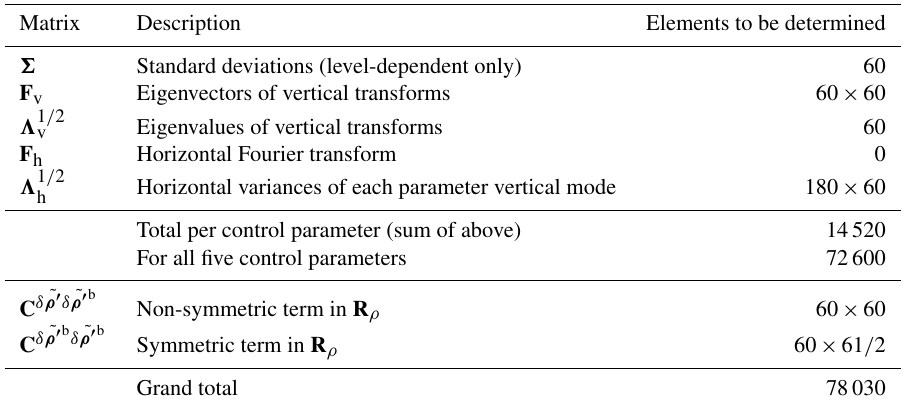
Table A1. The numbers of components of the spatial transforms that need to be estimated from data. The numbers of elements in the third column are for the standard ABC system of 360 longitudes and 60 levels. Note that for (cid:51) 1 / 2 , 180 wavenumbers are specified rather than 360 h as the negative wavenumbers are assumed to have the same variances as the positive ones. Matrix Description Elements to be determined (cid:54) Standard deviations (level-dependent